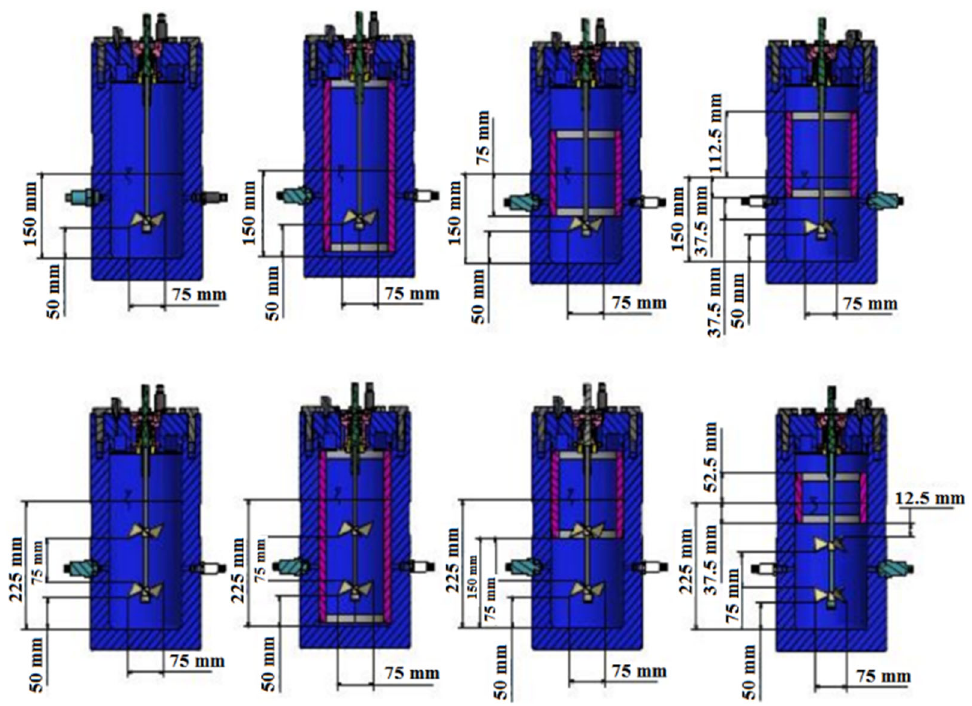
Figure 10. Dimensions for four single and four dual ‐ impeller experiments with the butterfly tur ‐